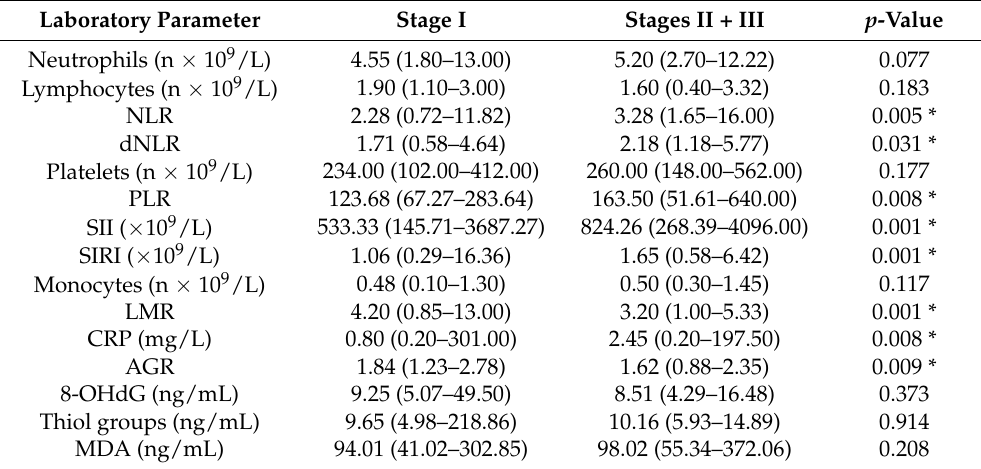
Table 2. The difference in preoperative inflammatory and redox biomarkers between testicular GCT patients at lower and higher tumor stages.